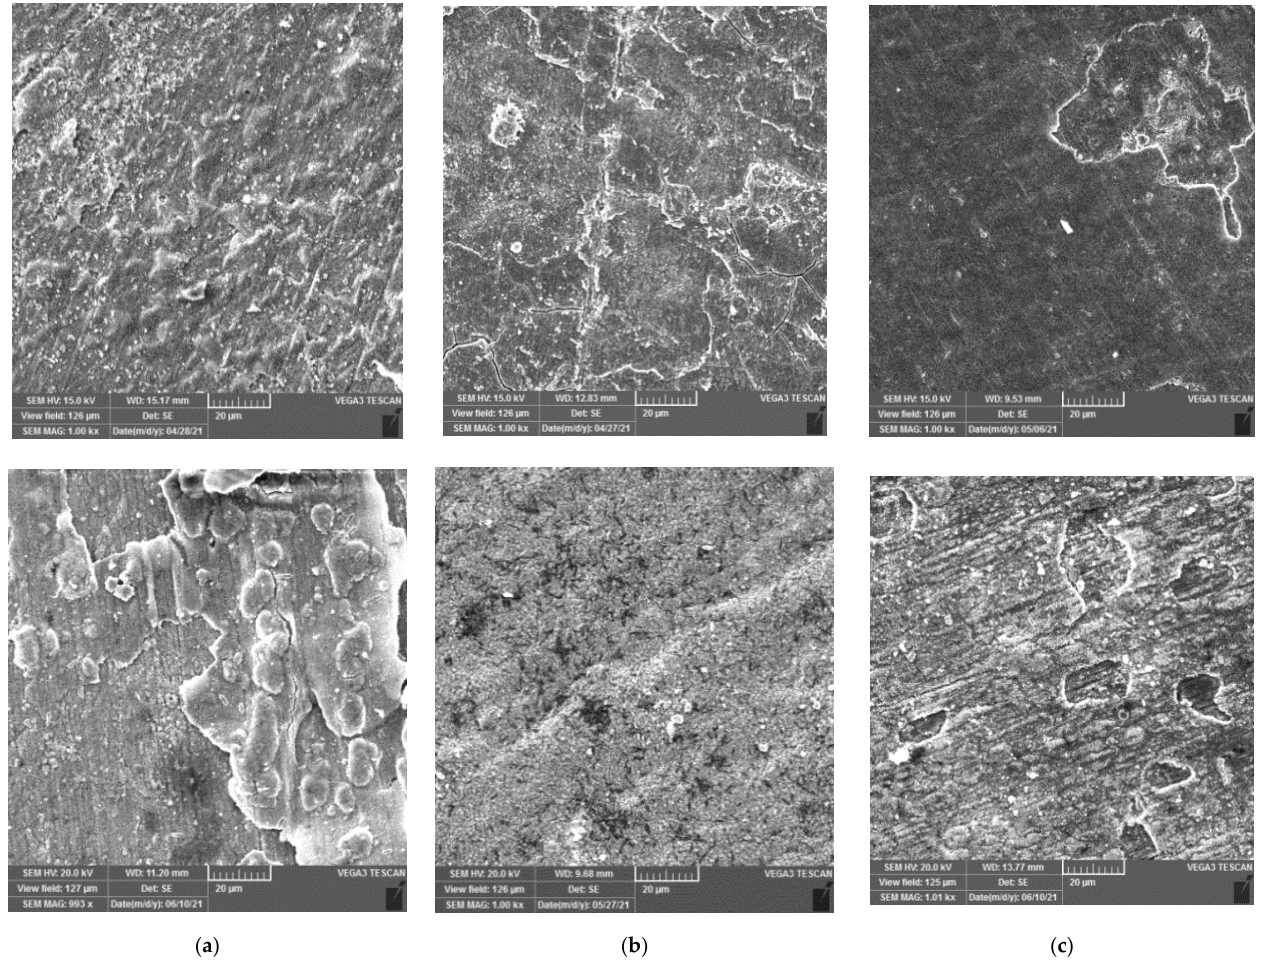
Figure 15. SEM images of ( a ) RG7, ( b ) CuSn6, and ( c ) CuSn12 bronzes before (upper image) and after (lower image) continuous exposure to urban rain. Scale bare in each image represents 20 μ m.